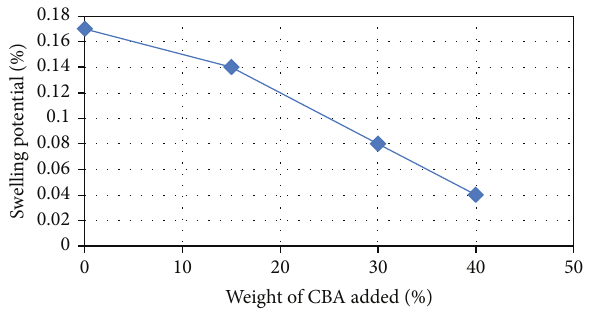
Figure 7: Graph showing swelling potential (%) with increasing CBA content